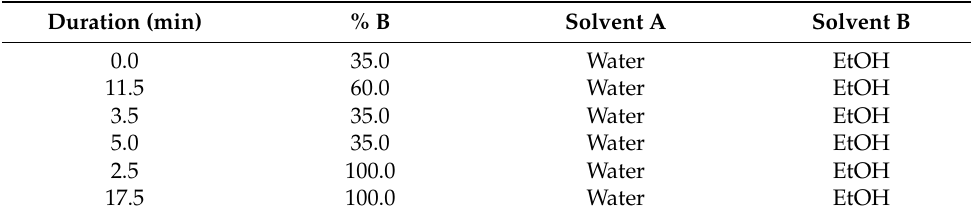
Table 1. The Gradient of mobile phase for separating capsaicinoids.